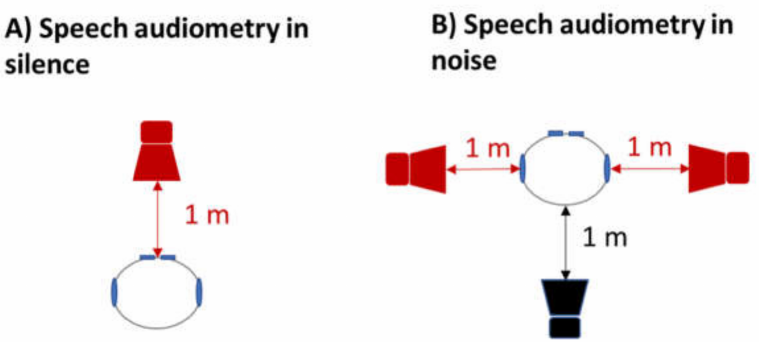
Figure 1. Top view of the position of the speakers for ( A ) the speech audiometry in silence test and ( B ) the speech audiometry in noise test. The red speakers are for the speech signal. The black speaker is for the noise